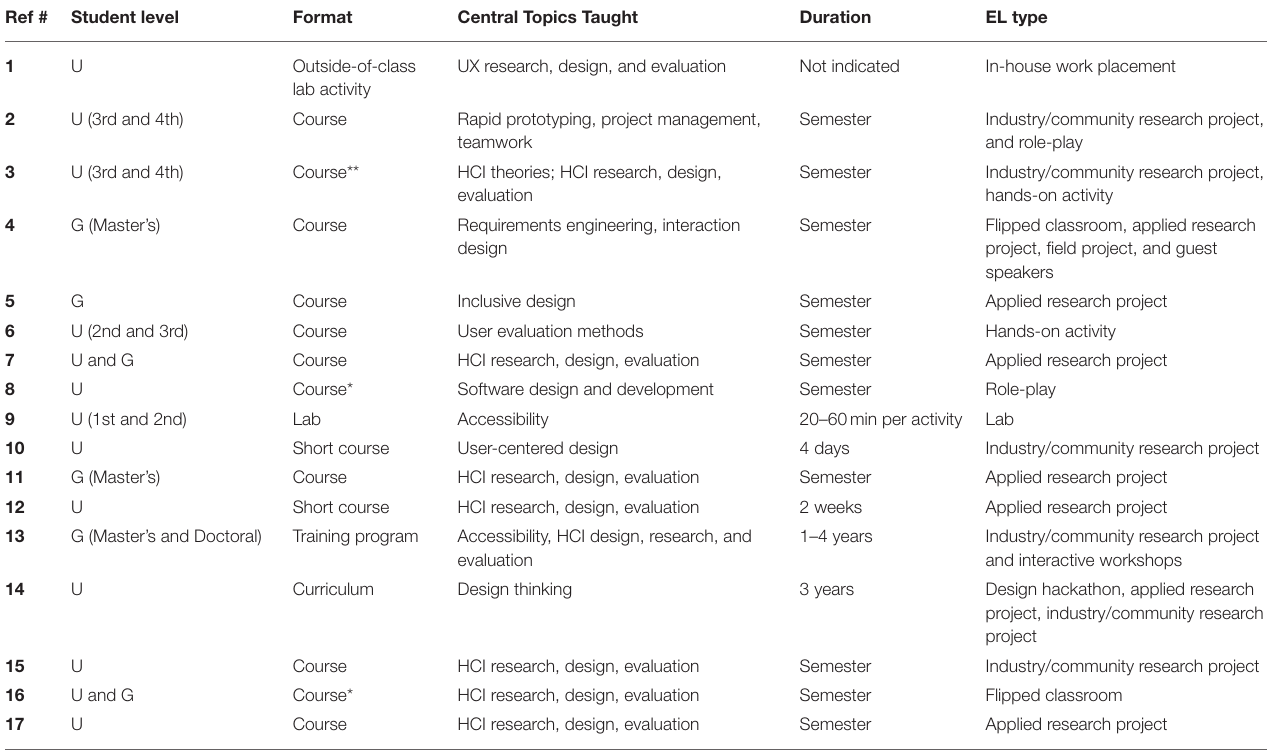
TABLE 5 | A list of EL type and respective